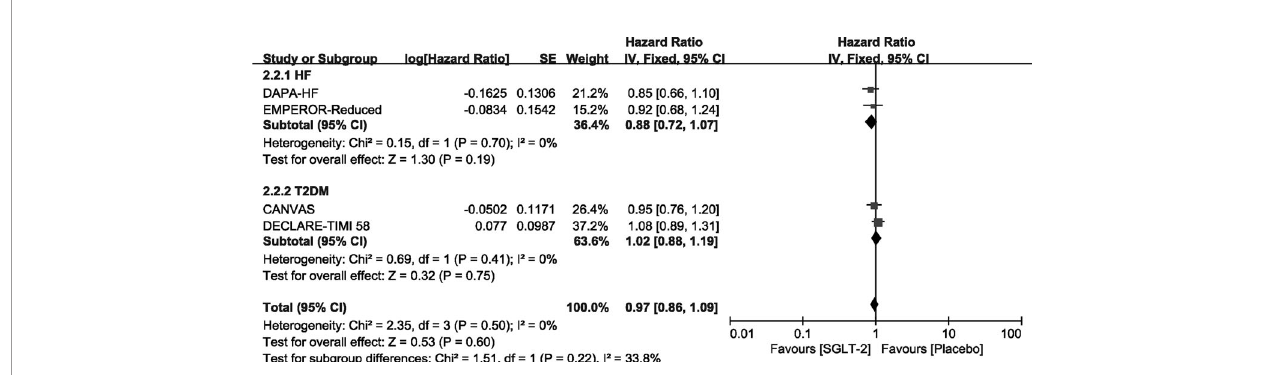
FIGURE 6 | Outcome of CV death in patients with T2DM or HF.